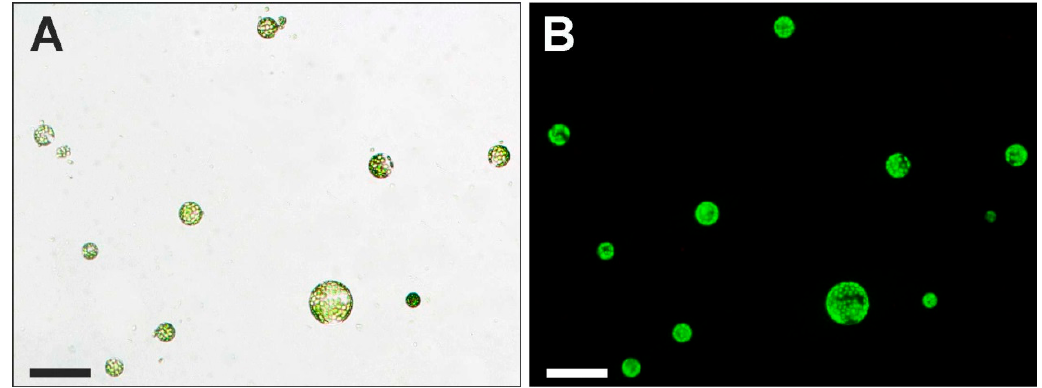
Figure 9. Freshly isolated protoplasts: ( A ) bright field and ( B ) stained with FDA – test of protoplast viability (UV light). Scale bars: 100 μ m. viability (UV light). Scale bars: 100 µ